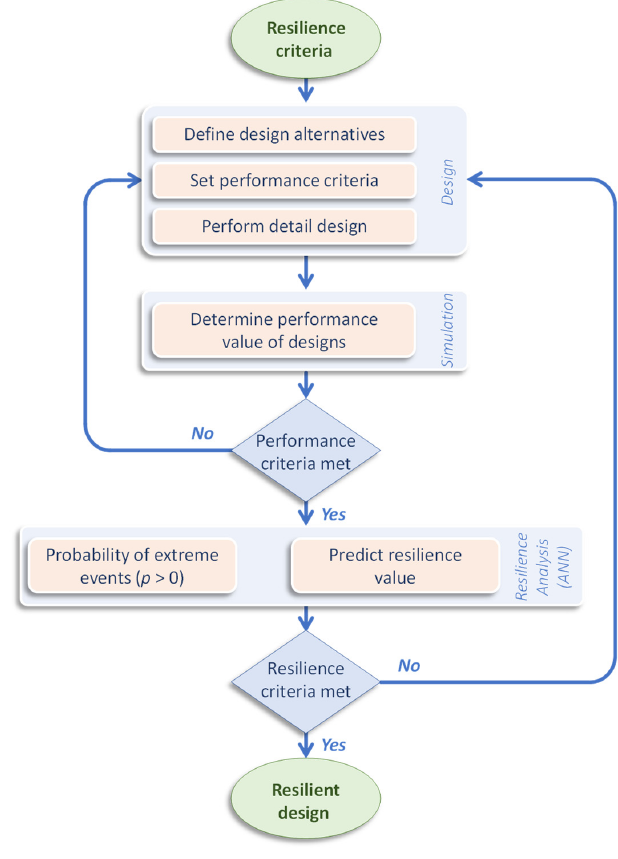
Figure 2. Flexible pavement resilience framework.